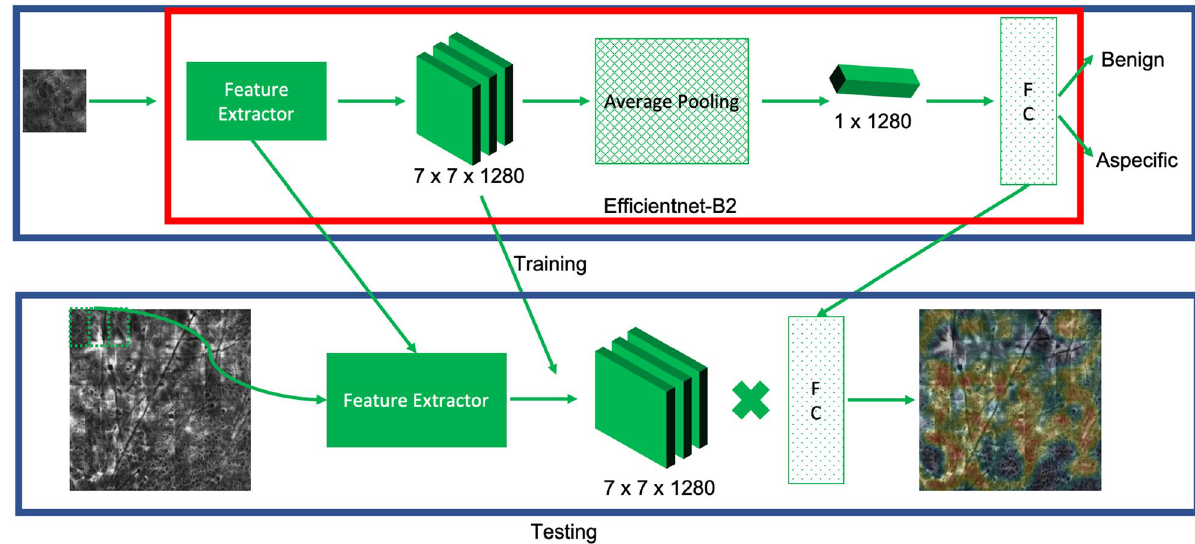
Figure 12. An overview of the algorithm—Efficientnet-B2 is trained for classification in the standard manner (note that FC denotes the fully connected final layer). In testing, the mosaic is broken up into patches that are fed to the feature extractor. The extracted features are then multiplied by the weights in the fully connected layer to create a